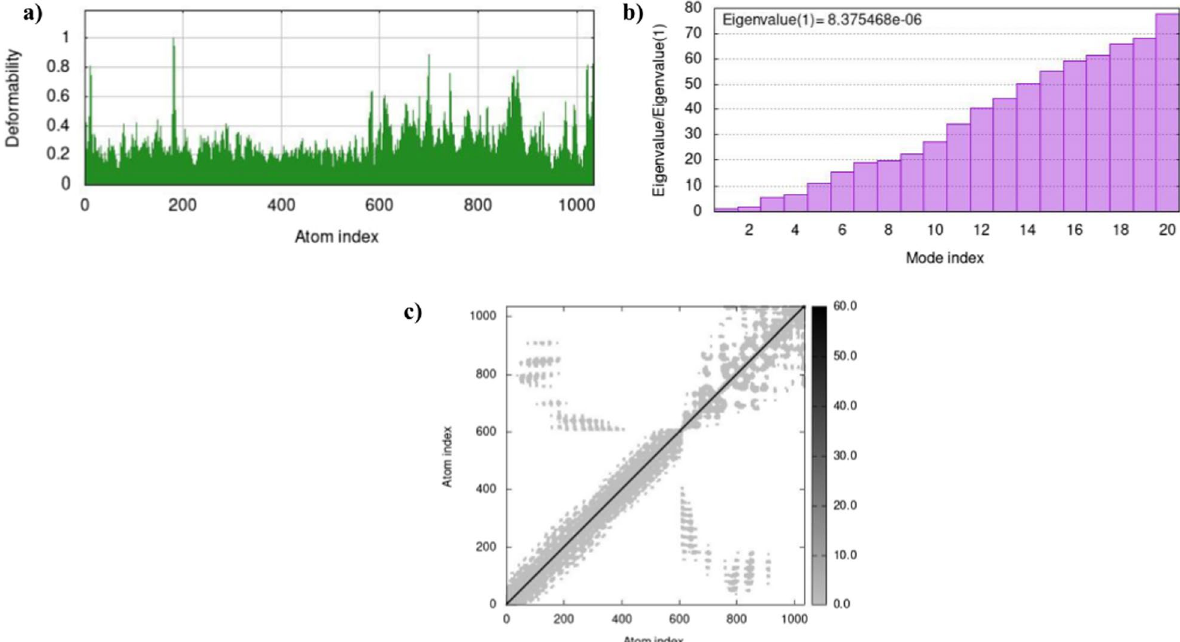
Fig. 9 a Deformability, b Eigenvalue, and c Elastic network of our constructed vaccine protein